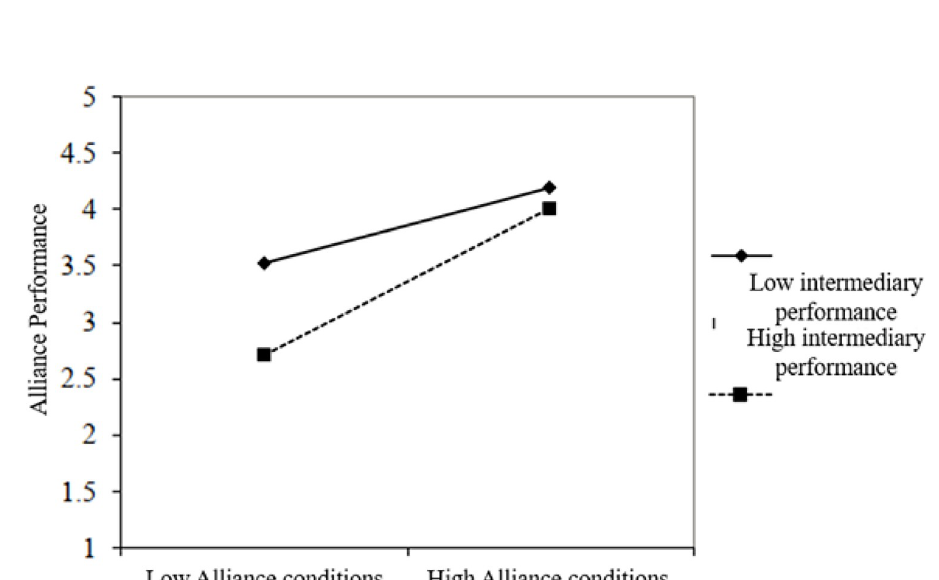
Fig 5. The relationship of intermediary performance to alliance conditions and alliance performance.